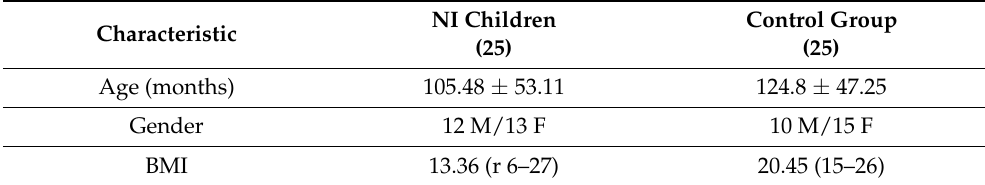
Table 1. Patients’ characteristics with differences between the two groups.